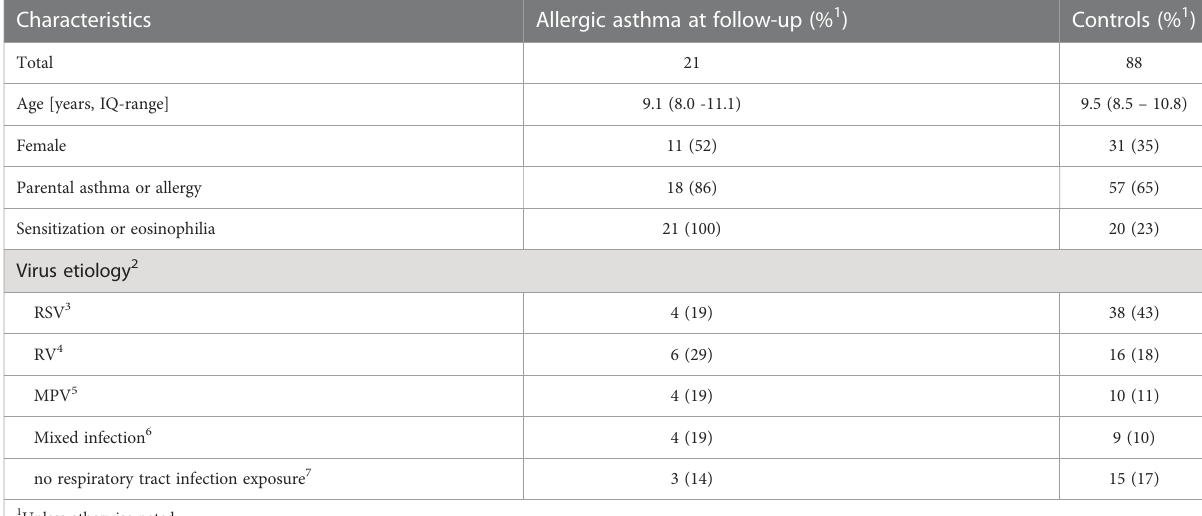
TABLE 2 Clinical characteristics study